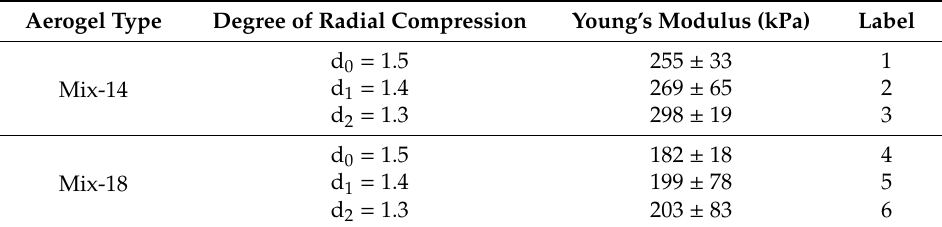
Table 3. Young’s modulus (kPa) for each SSMPA type and condition.